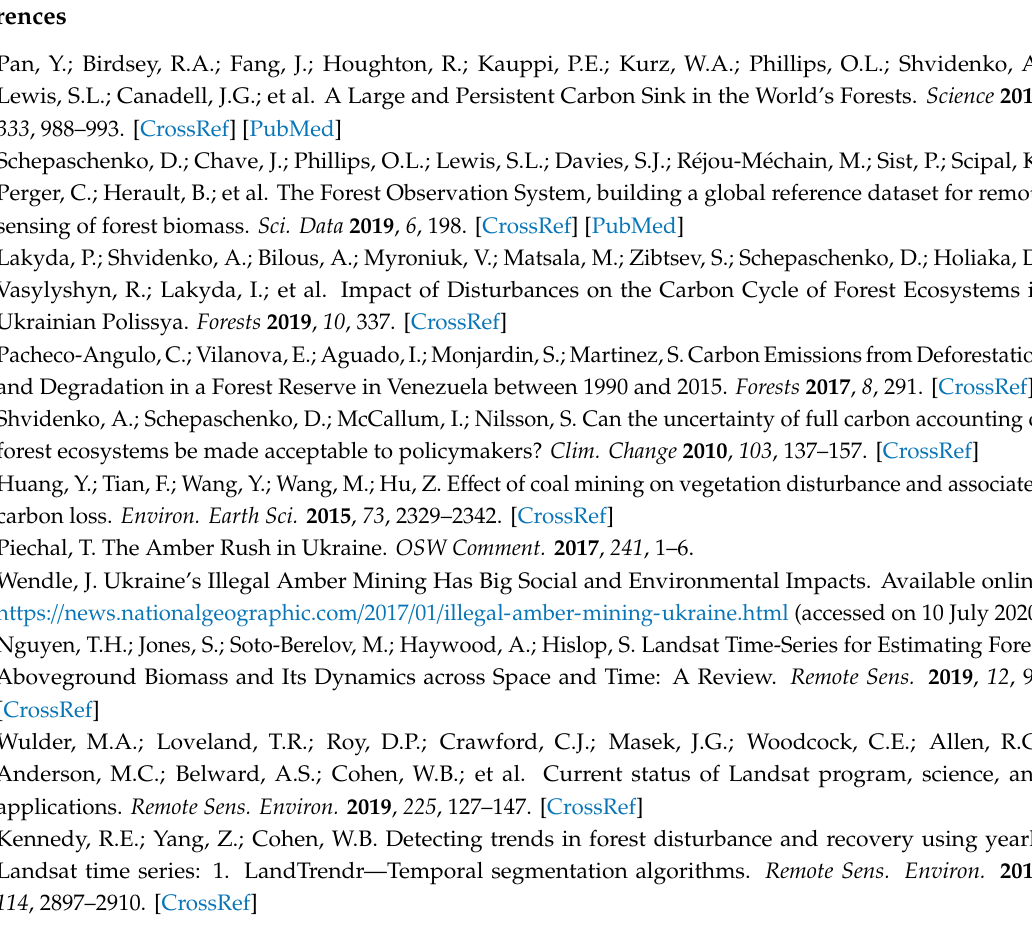
3. Figure S4. Examples of VR360 panoramic images of high level of disturbance caused by amber mining